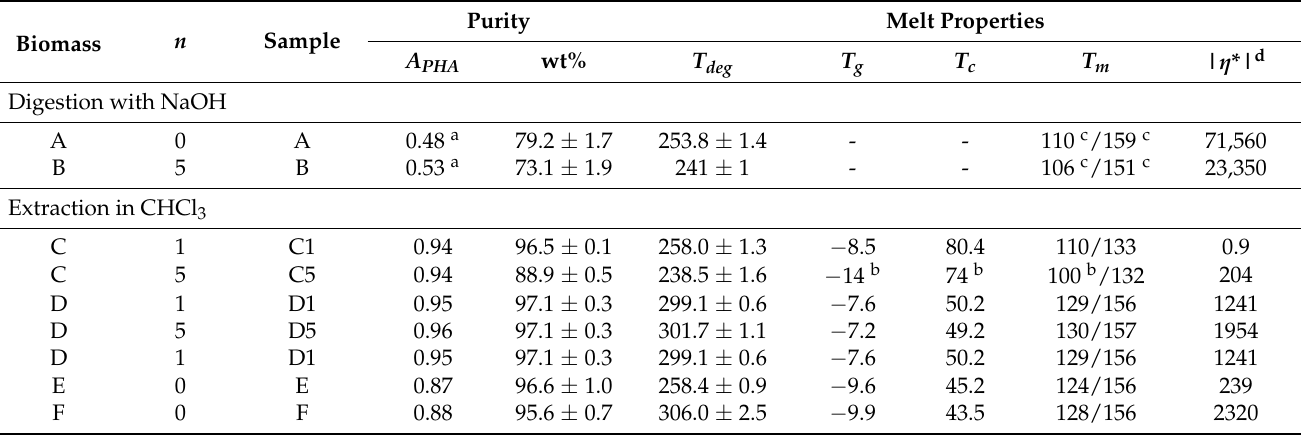
a : Computed from DRIFT spectra. b : Errors are 1, 2 and 5 °C for Tg, Tc and first Tm, respectively, whereas errors are 0.5 °C for all other samples. c : Measured from the first heating of the pellets, with an error of 1 °C. d : Measured at 170 °C and a frequency of 1 Hz.